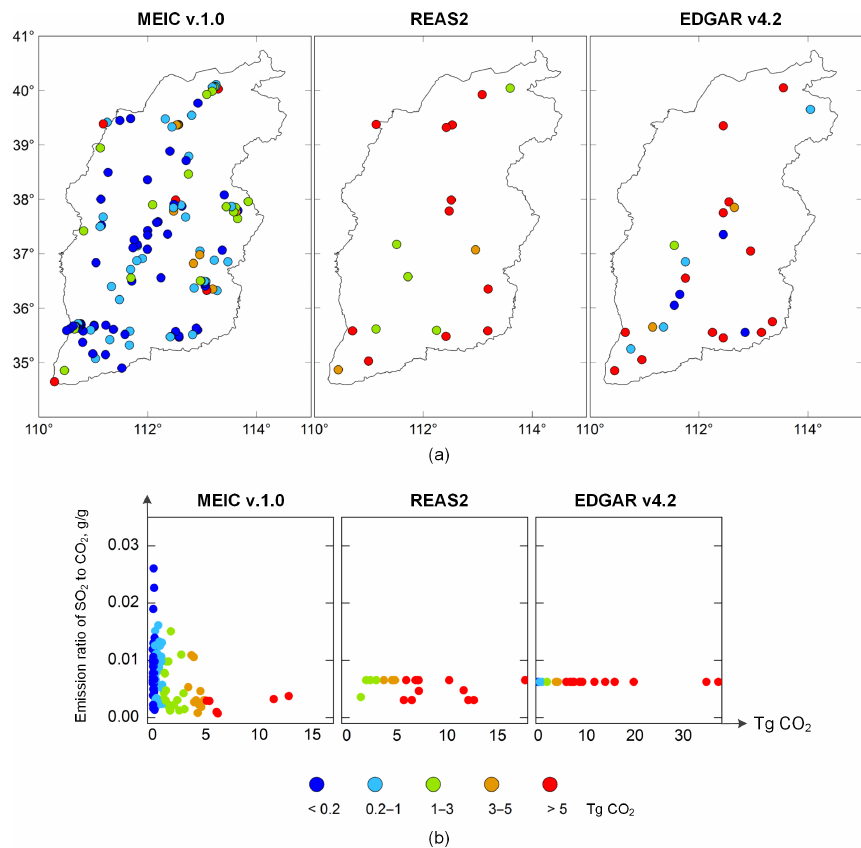
Figure 14. Comparison of 2008 power plants emission estimates between MEIC v1.0, REAS2, and EDGAR v4.2 for Shanxi province, China. (a) Spatial distribution of CO 2 emissions and (b) emission ratios of SO 2 to CO 2 . CO 2 emissions are grouped by